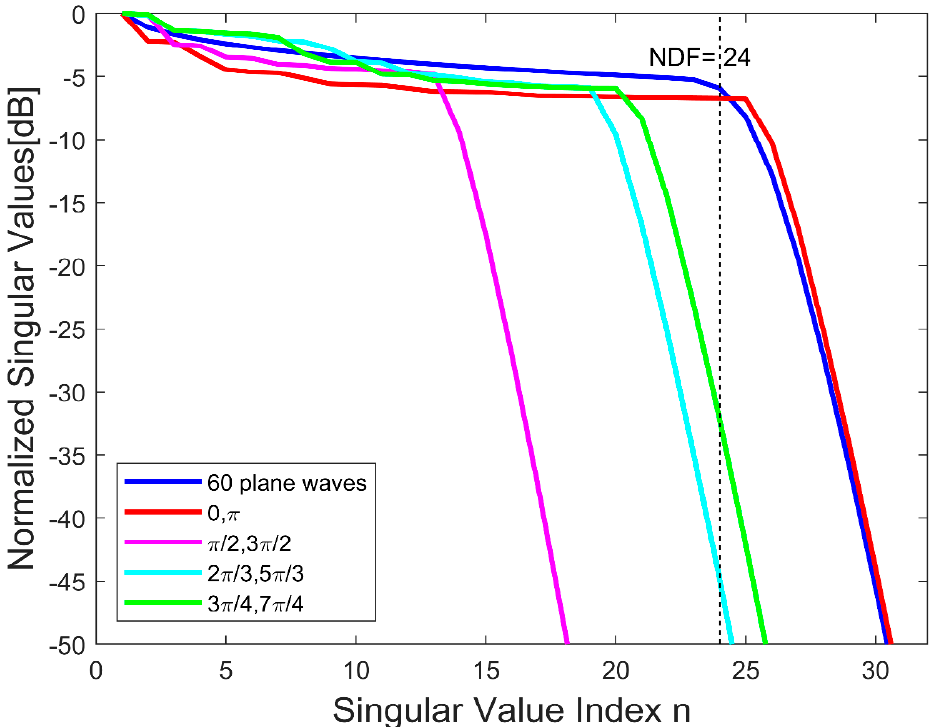
Figure 4. The behavior of the normalized singular values of the L θ operator for different couples of plane waves impinging from different directions.